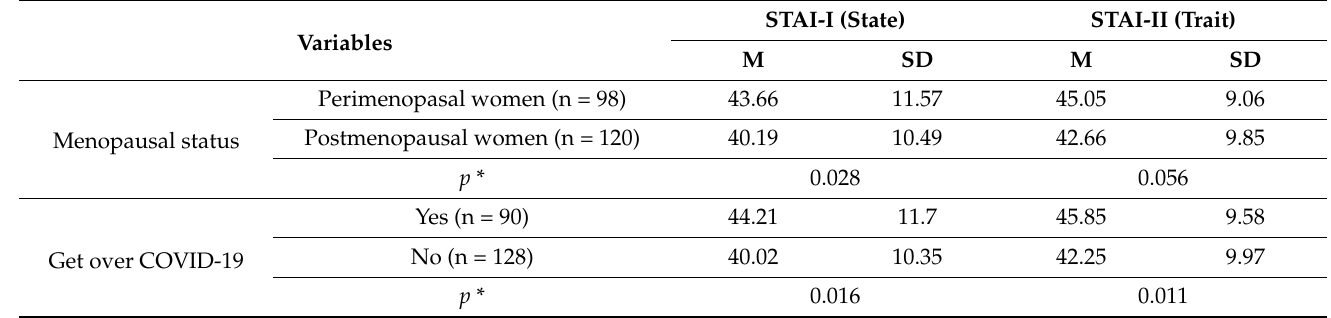
Table 4. The anxiety (state and trait) of the respondents depending on menopausal status and get over COVID-19.